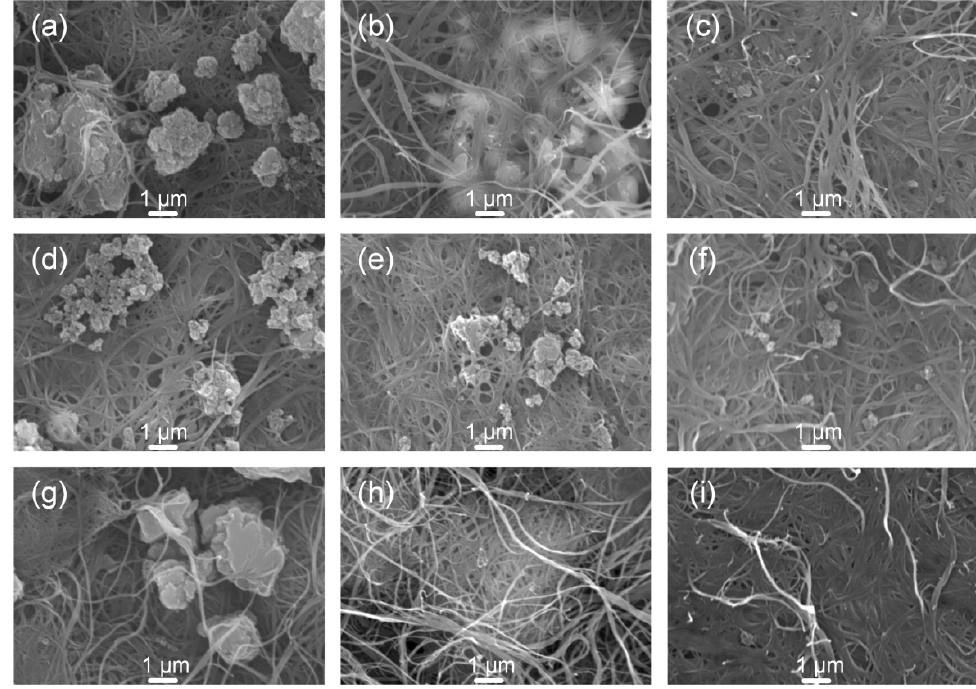
Figure 4. SEM images of the ( a – c ) PCo(epy) -SWCNT, ( d – f ) PNi(epy) -SWCNT, and ( g – i ) PCu(epy) -SWCNT composites films with the doping ratio ( f C ) of 15% (left column), 60% (middle column), and 90% (right column).